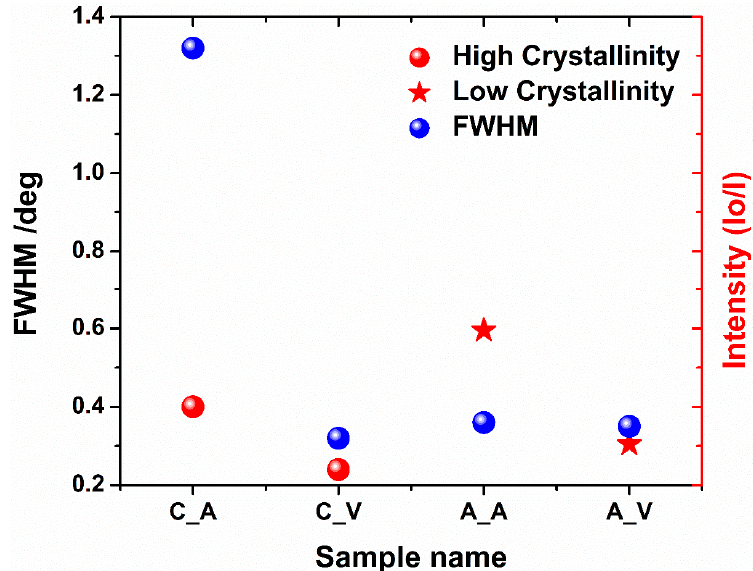
Figure 5. The ratio between intensities of anatase and substrate peaks for amorphous (A_A, A_V) and calcined (C_A, C_V) TiO 2 -45 nanotubes laser-treated in air (A_A, C_A) and under vacuum (A_V, C_V) conditions. For the reason of mathematical logic, for calcined samples Io states for intensity of anatase and I—for intensity of the substrate, while for amorphous ones—vice versa.